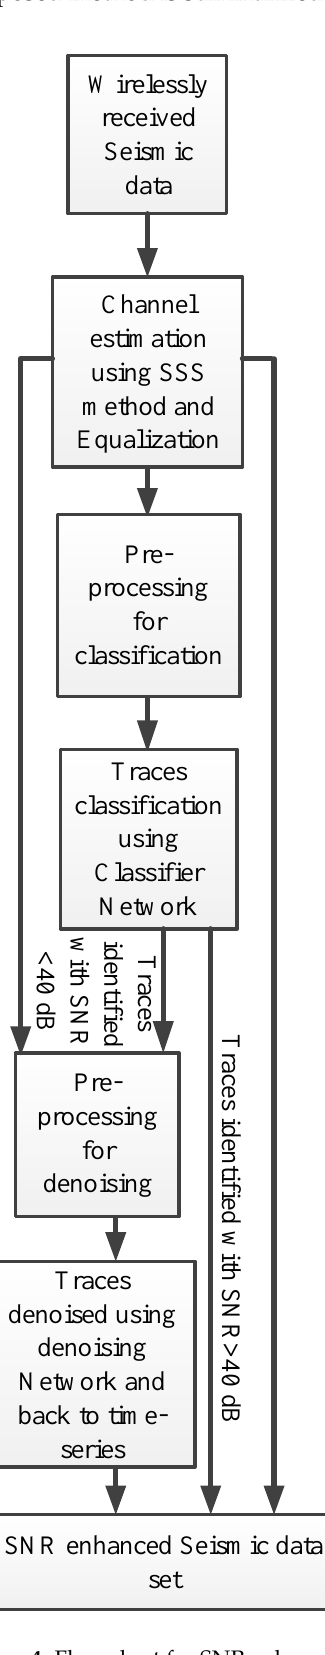
Figure 4. Flow chart for SNR enhancement of seismic data